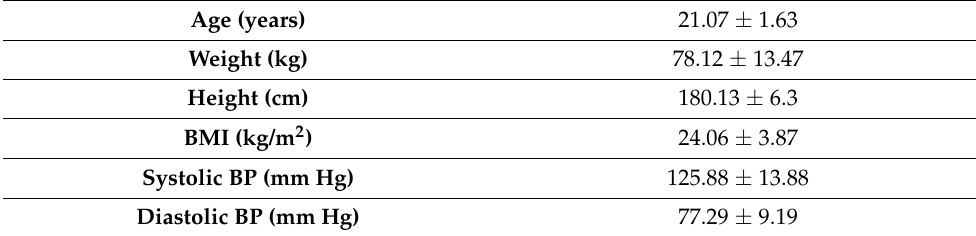
Table 1. Anthropometric characteristics of the study